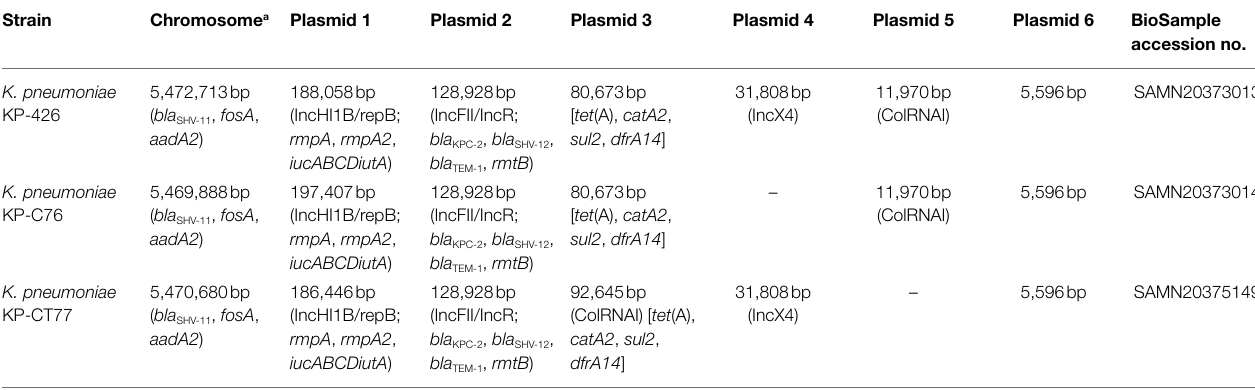
TABLE 2 | The genomes and their sizes of three